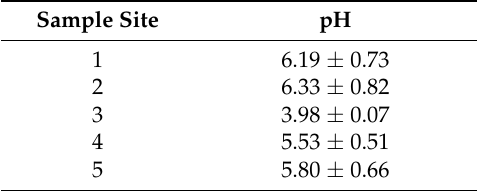
Table 3. The mean levels of the pH in the Smolnik River.